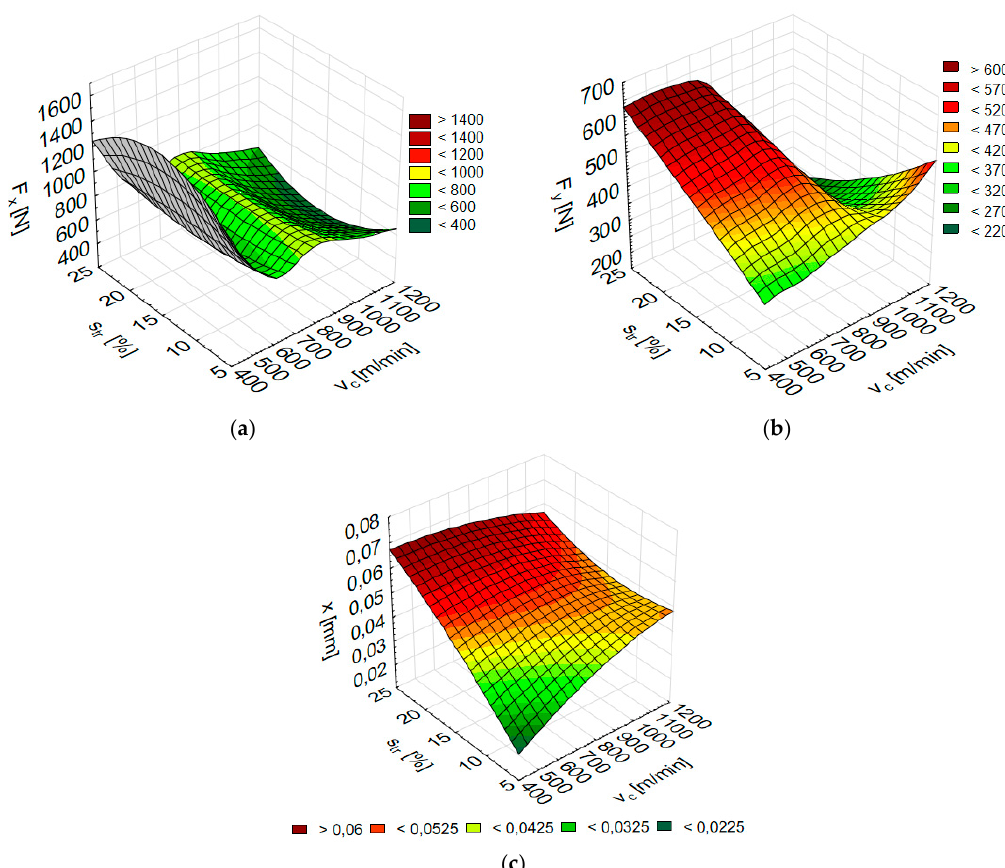
Figure 13. Numerical results of ( a ) Fx, ( b ) Fy and ( c ) x depending on the cutting speed v c and trochoidal step s tr for AZ91D alloy (F x : RBF 2-5-1, F y : MLP 2-3-1, x: MLP 2-6-1).